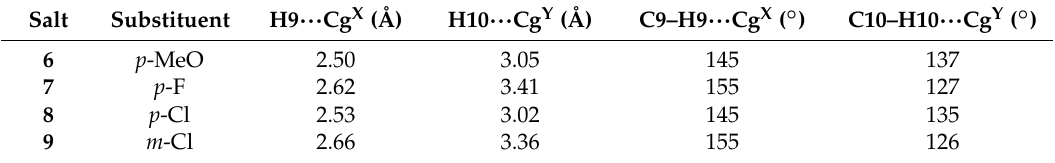
Figure 11. Sheet structure in crystalline salt 9 , consisting of 2 1 columns. The pale-blue lines show salt bridges and hydrogen bonds. See Table 3 for the interatomic distances d 1 – d 4 . Table 5. Geometrical parameters of the homo-aromatic C–H ∙∙∙π interactions between the naphthyl groups in salts 6 – 9 1 .